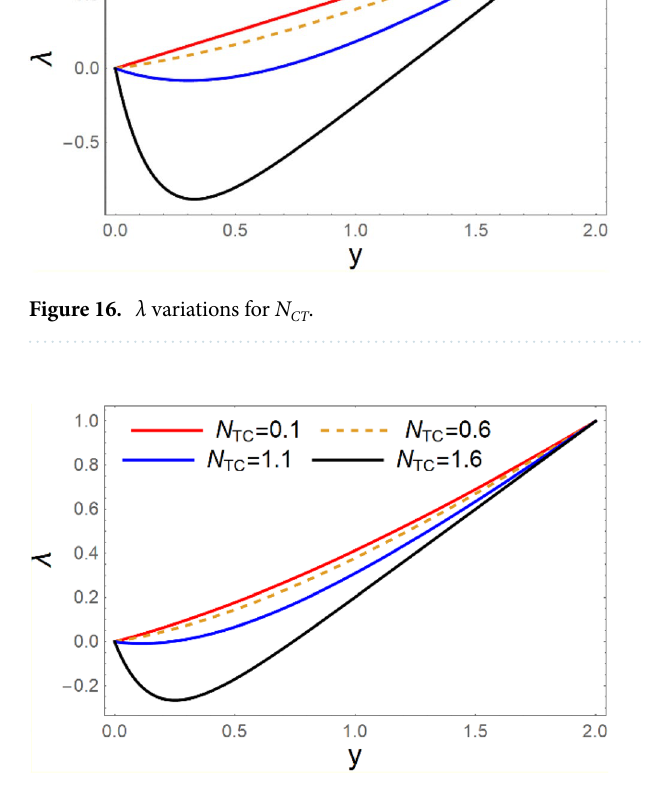
Figure 17. λ variations for N TC .